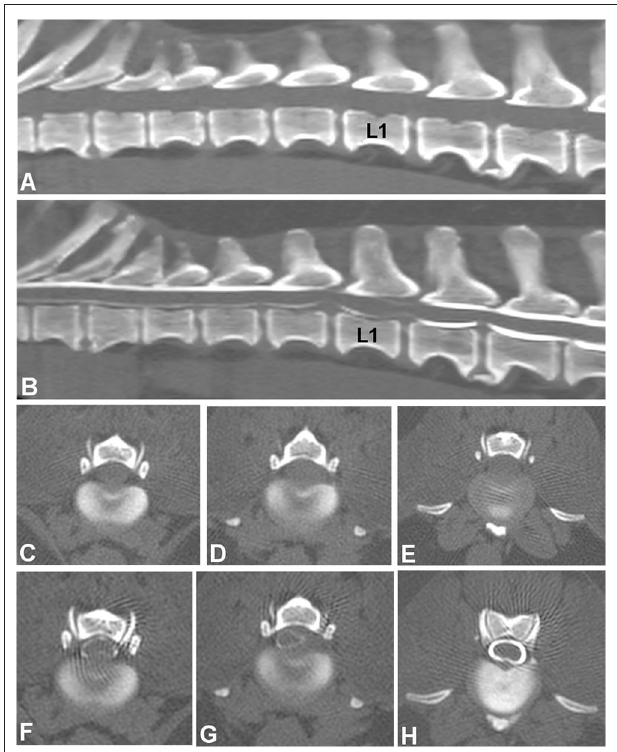
FIGURE 3 | Images of a 10-year old female spayed Beagle presented with an acute onset of non-ambulatory paraparesis and spinal pain. (A) Sagittal non-contrast CT image revealing areas of spondylosis and no obvious compressive lesion. (B) CT-myelography shows areas of ventral subarachnoid space compression at T13-L1, L1-2, and L2-3. Thinning of dorsal and ventral contrast columns is noted between L1-2. (C–E) images show transverse non-contrast CT images representing T13-L1, L1-2, and L2-3 intervertebral levels, respectively. Peridural fat is lost at L1-2 level. (F–H) CT-myelographic images at levels T13-L1, L1-2, and L2-3. Ventral, lateral and dorsal spinal cord compressions are noted at L1-2. Surgical decompression and biopsy confirmed that the compressive material was extruded disc